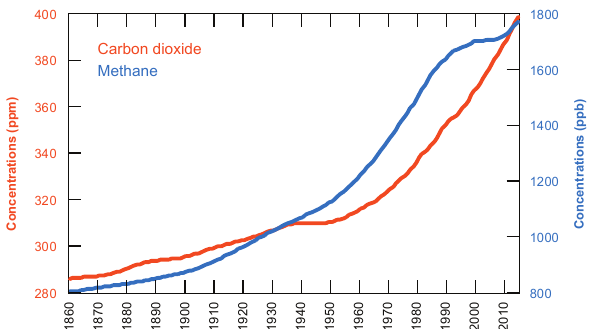
Figure 1. Atmospheric concentrations of carbon dioxide in parts per million (orange) and methane in parts per billion (blue) used in this study (Meinshausen et al., 2011b). Note that concentrations are prescribed for CM3 throughout this time period, but only pre- scribed for MAGICC through 2005, of which methane emissions inputs drive the model from 2006 to 2014. The resulting concentra- tions are plotted